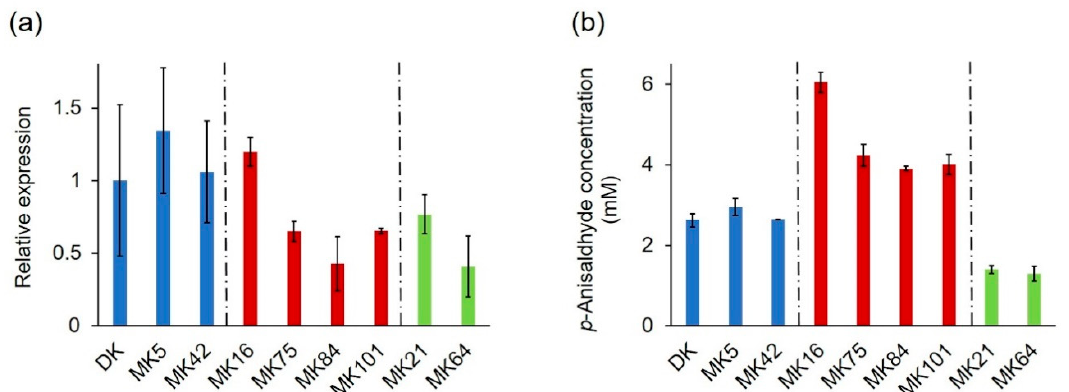
Figure 10. Relative expression of the PsaPOX gene ( a ) in comparison to the alkene cleavage activity, and ( b ) of selected monokaryons and the dikaryotic P. sapidus strain. Expression rates were normalized to the expression of the parental dikaryon. Values are the average of three (expression) or two (alkene cleavage activity) independent biological replicates with standard deviations shown as error bars. P. sapidus strains were grouped according to their PsaPOX sequence (blue: PsaPOX_DK; red: PsaPOX_high; green: PsaPOX_low).